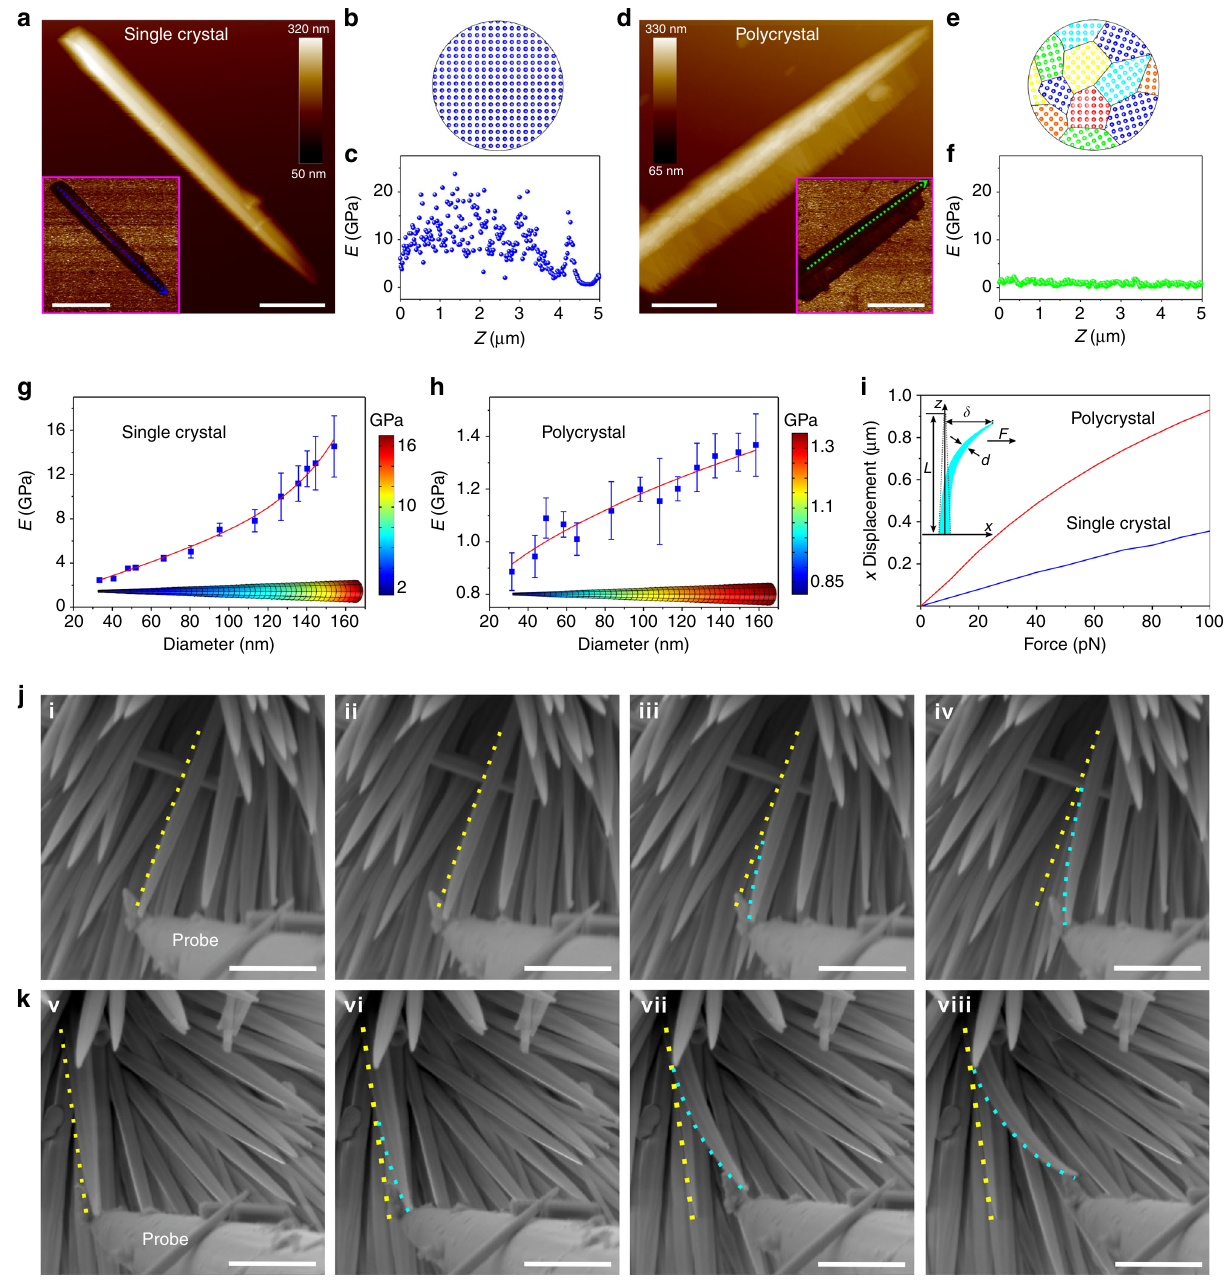
Fig. 2 Nanomechanical properties of NWs. a Atomic force microscopy (AFM) height channel visualizing a single-crystalline NW. The inset shows the corresponding Derjaguin — Mueller — Toporov (DMT) Young ’ s modulus map. Scale bars in a and inset are 1 and 2 μ m, respectively. b Schematic representation of the NiCo(OH) 2 CO 3 NW with one crystal domain. c Pro fi le analysis of Young ’ s modulus map along the blue dashed line. d AFM height channel visualizing a polycrystalline NW. The inset shows the corresponding DMT Young ’ s modulus map. Scale bars in d and inset are 1 and 2 μ m, respectively. e Schematic representation of the NiCo 2 O 4 NW with nanoscale multi-crystal domain. f Pro fi le analysis of the Young ’ s modulus map along the green dashed line. g , h Experimental Young ’ s modulus of NWs as a function of diameter size and simulated Young ’ s modulus distributions along a single NW by COMSOL software. g Single-crystalline and h polycrystalline NWs. Error bars: standard error ( n = 3). i Relationship between the applied force parallel and the lateral de fl ection distance ( x displacement) determined by FEM using the non-linear mode in the COMSOL software. The inset shows the geometric parameters for a bent NW depicting the de fl ection ( δ ) when a force ( F ) is applied at the top. The bending properties of NWs in situ monitored by environmental SEM, j single-crystalline (i to iv) and k polycrystalline NWs (v to viii). Scale bars in j and k are 500